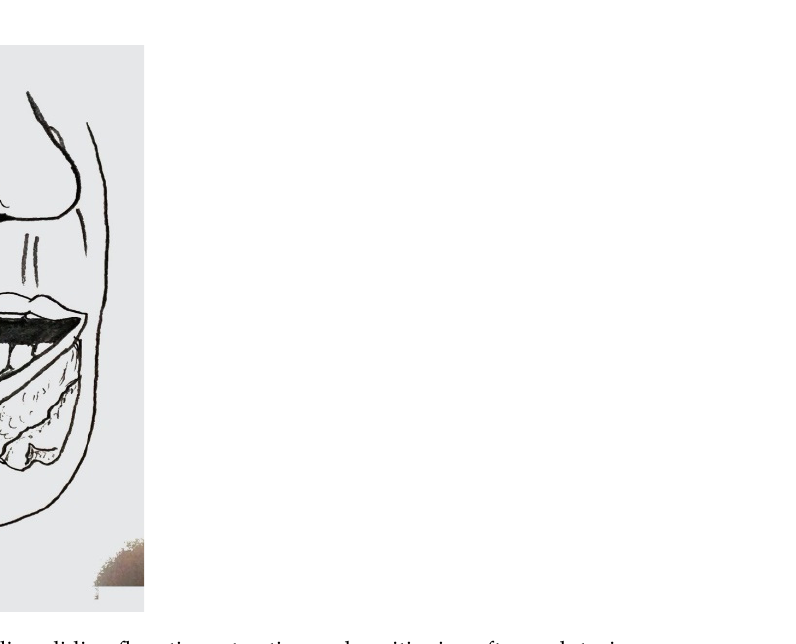
Figure A3. Vermillion sliding flap: tissue traction and positioning after sculpturing.